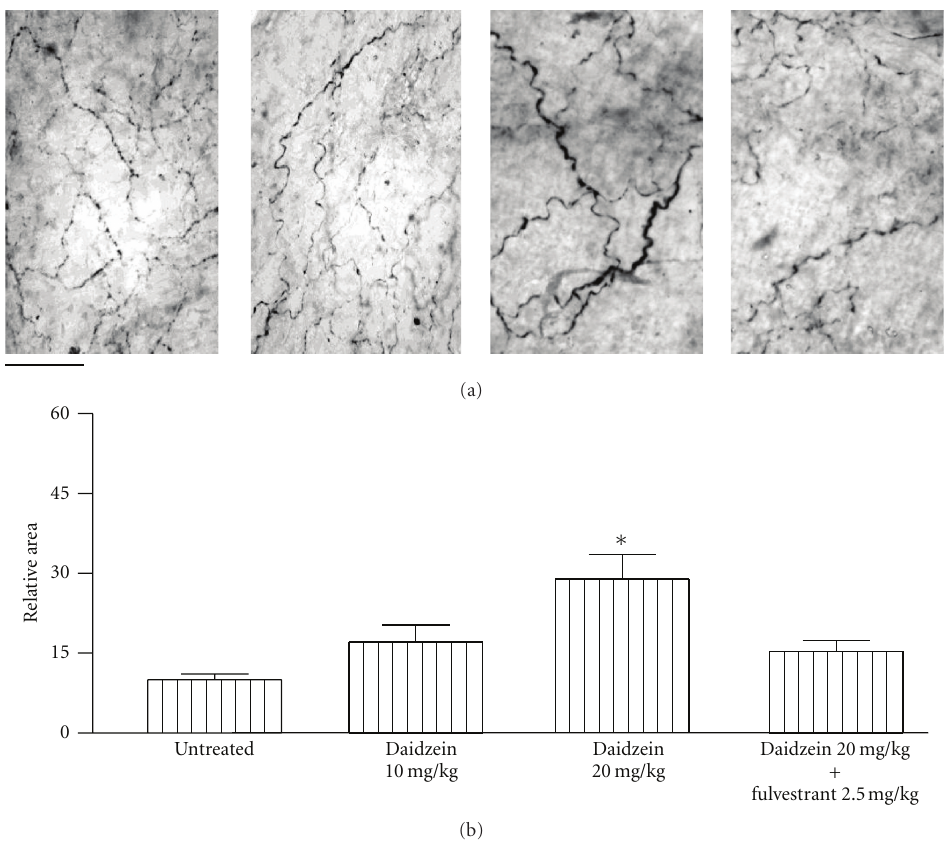
Figure 7: Immunohistochemistry for CGRP. (a) Representative microphotographs of CGRP-immunoreactive fibers surrounding mesenteric arteries in myenteric plexus preparations of OVX female rats. Daidzein (10mg/kg or 20 mg/kg p.o.) or daidzein plus fulvestrant (20mg/kg p.o. and 2.5mg/kg s.c., resp.) were administered daily during 3 days. The photomicrographs were captured at 400x magnification; the scale bar indicates 50 μ m. (b) Bars represent the mean ± SEM ( n = 4) of relative morphometric units measured as stained